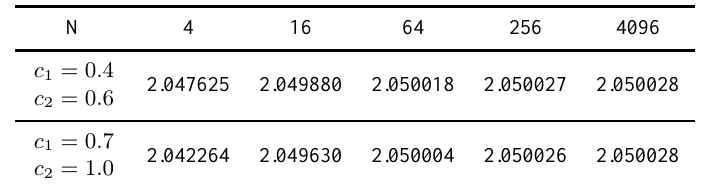
Table 3. Case d = 2 , m = 1 (cubic splines).